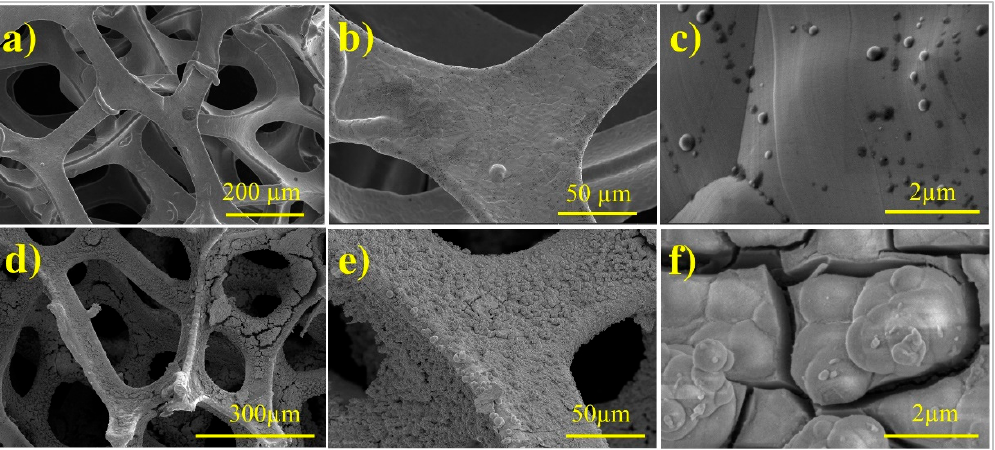
Figure 1. ( a – c ) low magnification SEM of bare NiF, ( d – f ) Low and high magnification SEM of